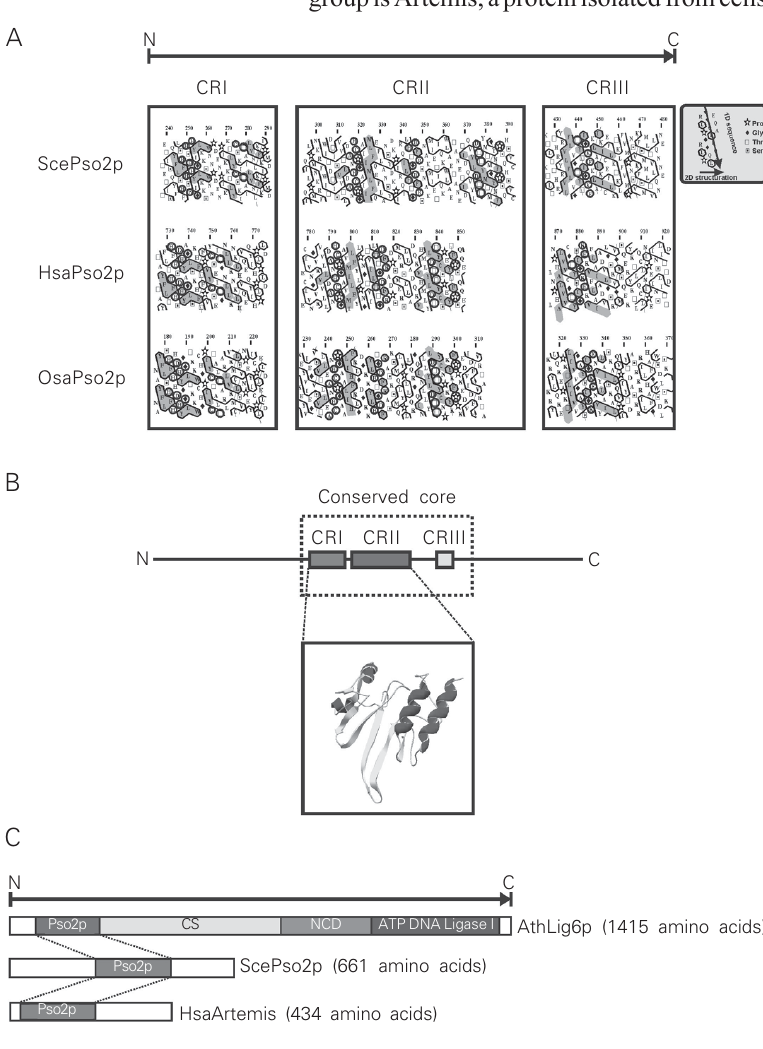
Figure 2. Hydrophobic cluster analysis of yeast ( Saccharomyces cerevisiae , Sce), human ( Homo sapiens , Hsa), and rice ( Oriza sativa , Osa) Pso2p sequences (A). The three conserved regions (CRI-CRIII) of the Pso2 catalytic core are indicated. Conserved hydrophobic amino acid residues appear in gray and conserved hydrophilic amino acid residues are contoured. The way to read the sequence and special symbols is indicated in the gray inset. In B , the Pso2p catalytic core is represented by a dotted box containing the three CRs. A three-dimensional model of CRI and CRII is shown inside the box. A comparison of ScePso2p, Arabidopsis thaliana Lig6p (AthLig6p), and HsaArtemis do- mains is shown in C . The length of sequences is given in parentheses and the direction of proteins, from N-terminus to C-terminus, is indicated by an arrow. CS = conserved sequence; NCD = non-catalytic